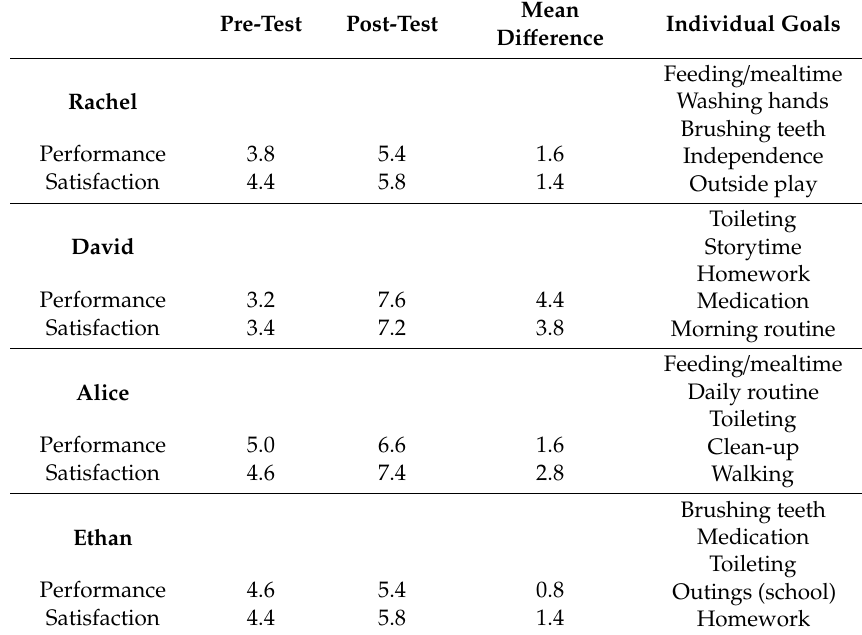
Table 6. Comparison of Canadian occupational performance measure (COPM) individual scores at pre-test and post-test intervention with corresponding participants